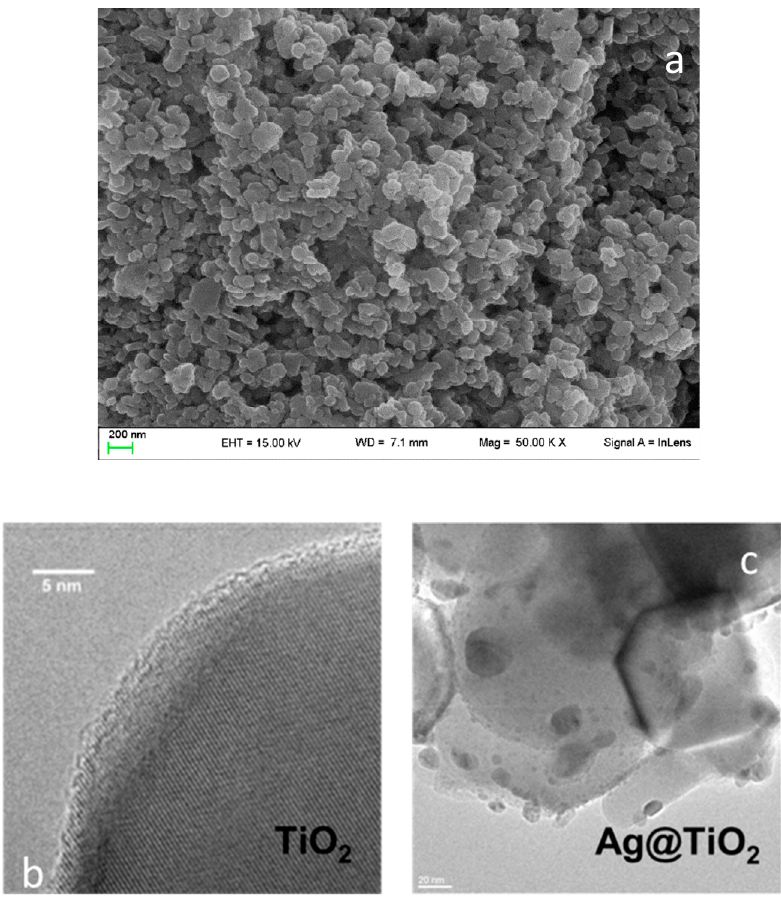
Figure 2. ( a ) HR-SEM image of Ag@TiO 2 coated onto a porcelain-grès tile; ( b ) HR-TEM image of bare TiO 2 ; and ( c ) HR-TEM image of Ag@TiO 2 samples.